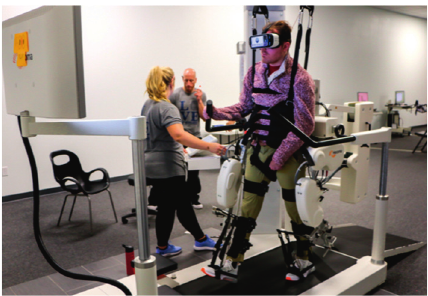
Figure 5: VR-based simulation